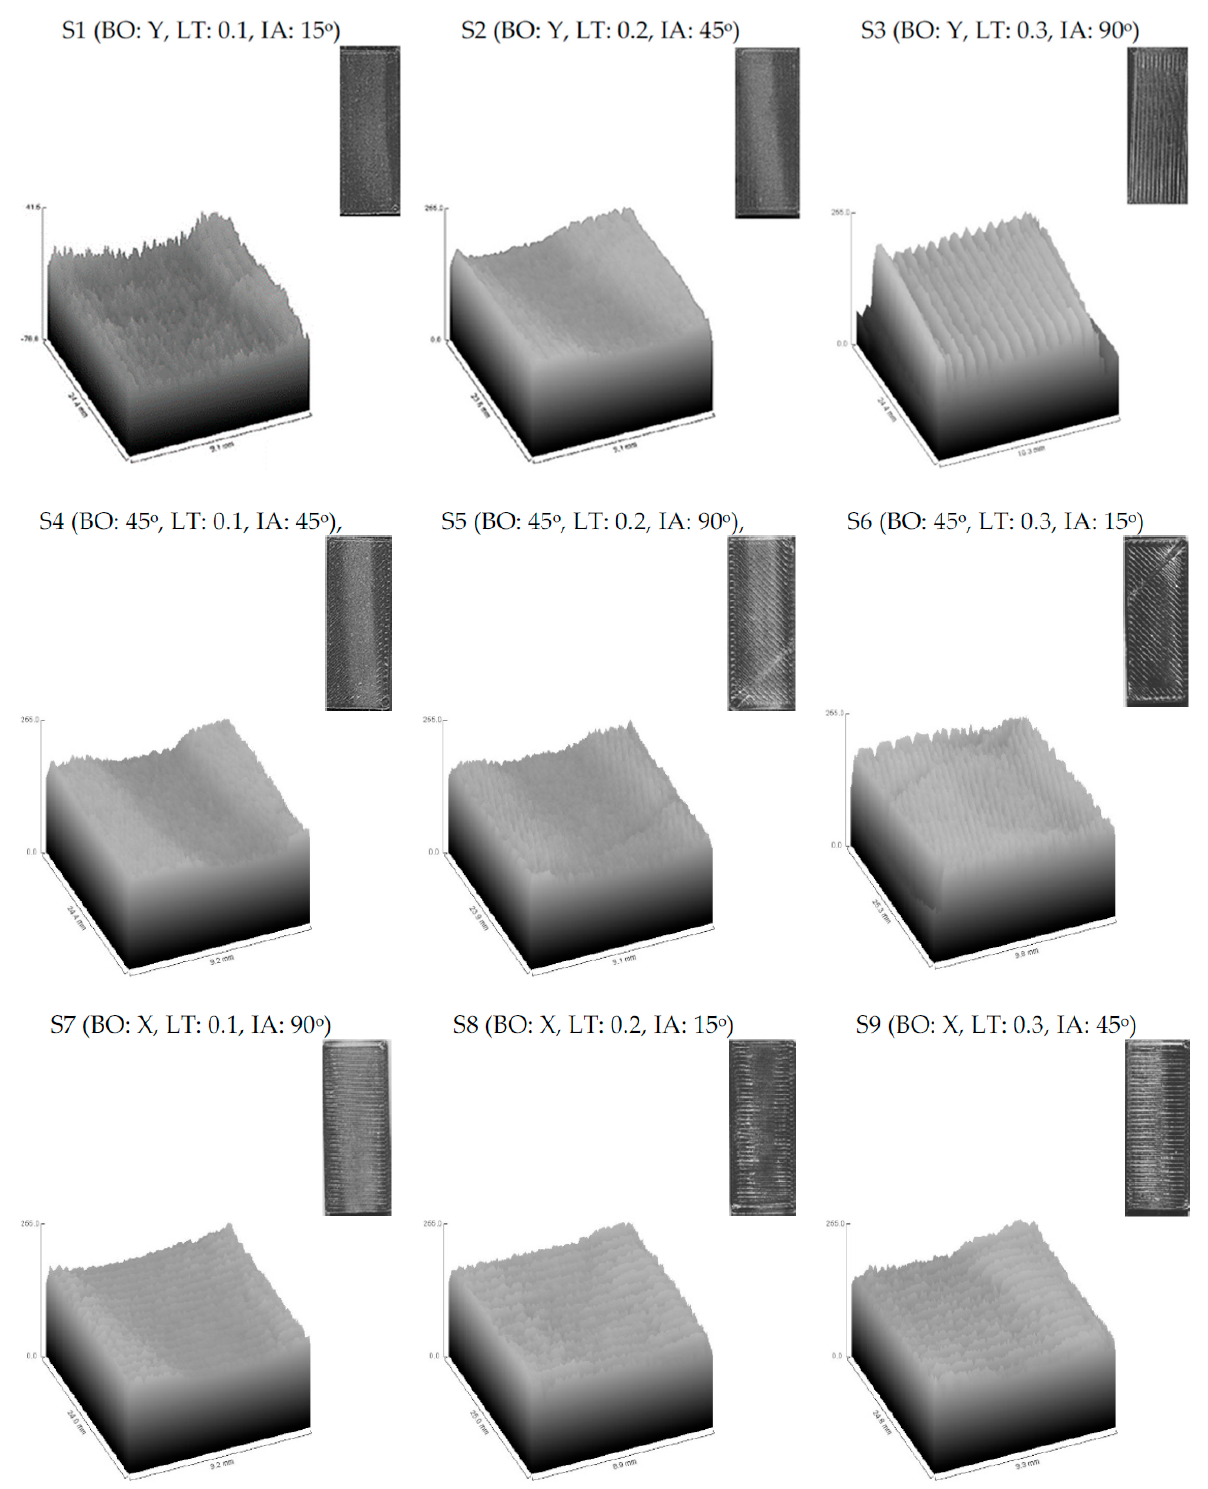
Figure 11. Representative 3D surface plots of surface topography of FDMed PLA specimens after subjecting to the slurry impacts.